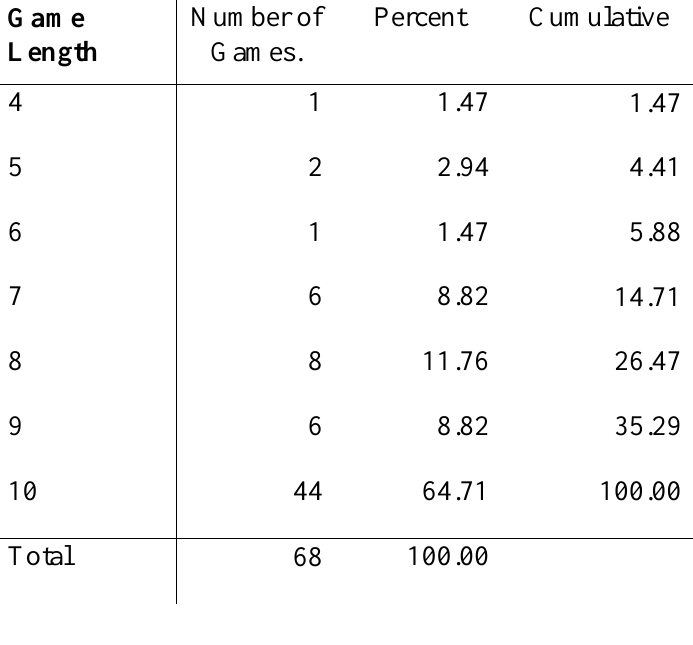
Table A2.4 Number of rounds played in the